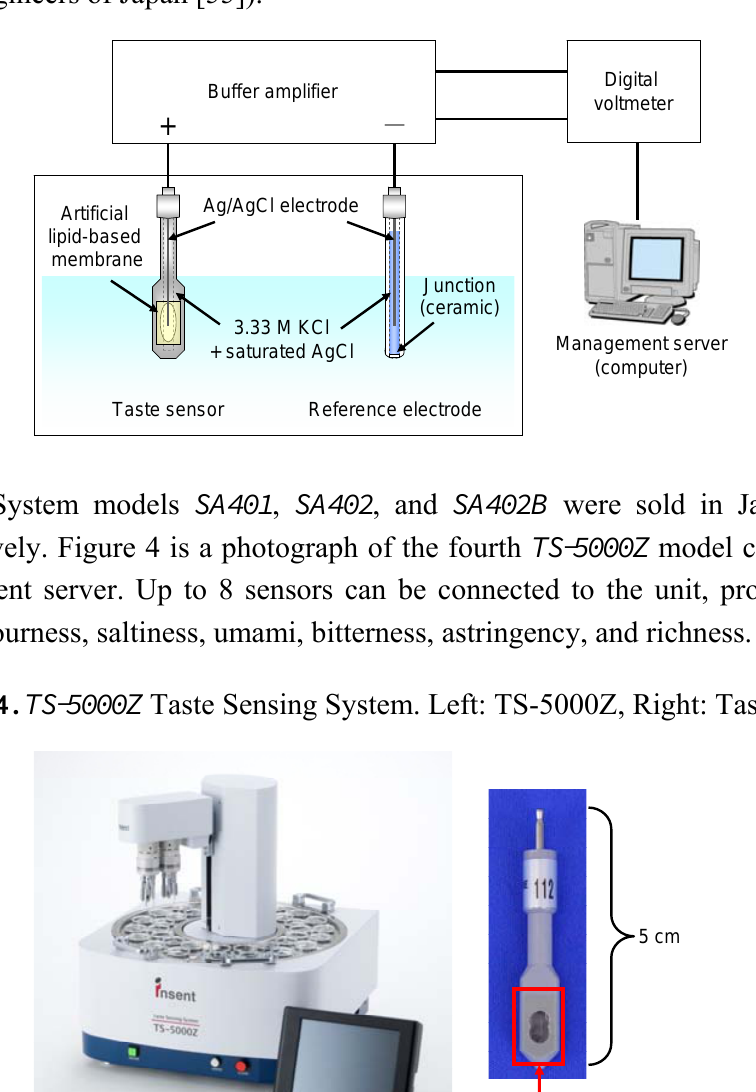
Figure 3. Diagram of taste sensing system (Reprinted with permission from the Institute of Electrical Engineers of Japan [55]).